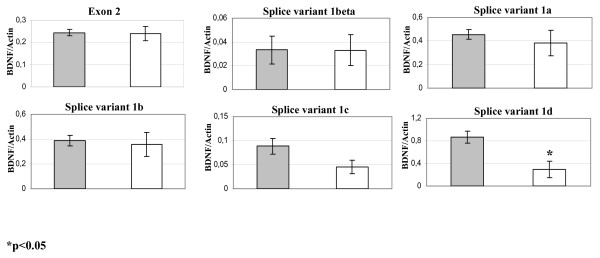
Histogram of semiquantitative-PCR of BDNF. Variants and coding exon in control are reported as grey bars, stressed samples are reported as white bars. Values are means ± SD; *p < 0.05. n = 5.